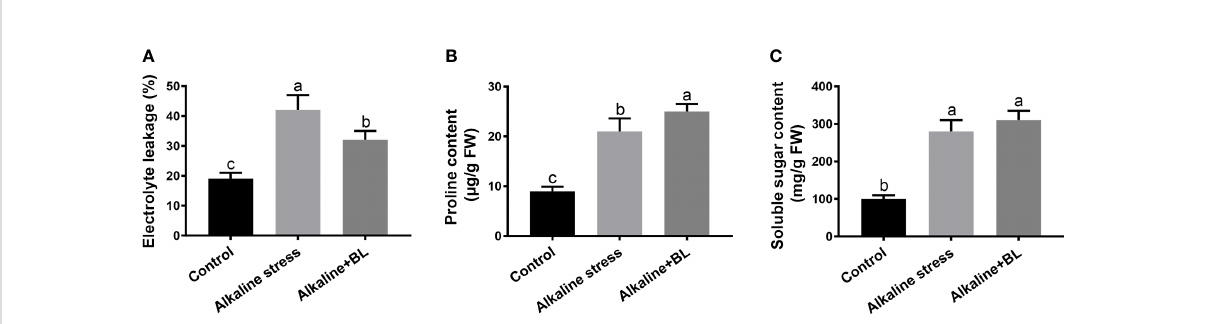
FIGURE 6 Effects of exogenous BL treatment on electrolyte leakage (A) , proline content (B) , and soluble protein content (C) under alkaline stress. The data represent the mean ± SD of three biological replicates. Different lowercase letters indicate signi fi cant differences according to Fisher ’ s least signi fi cant difference ( P <